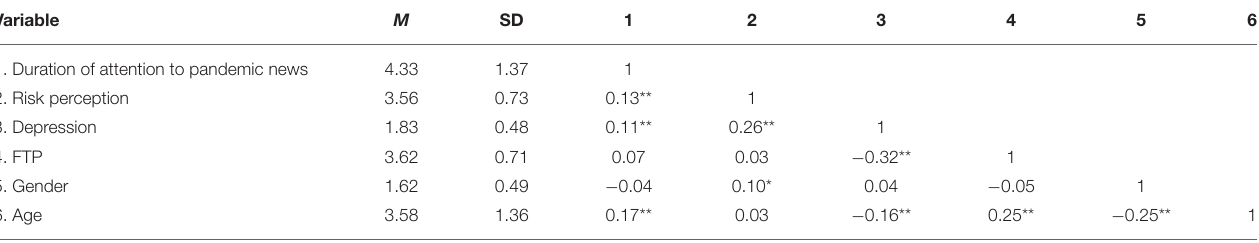
TABLE 2 | Means, standard deviations, and correlations. Variable